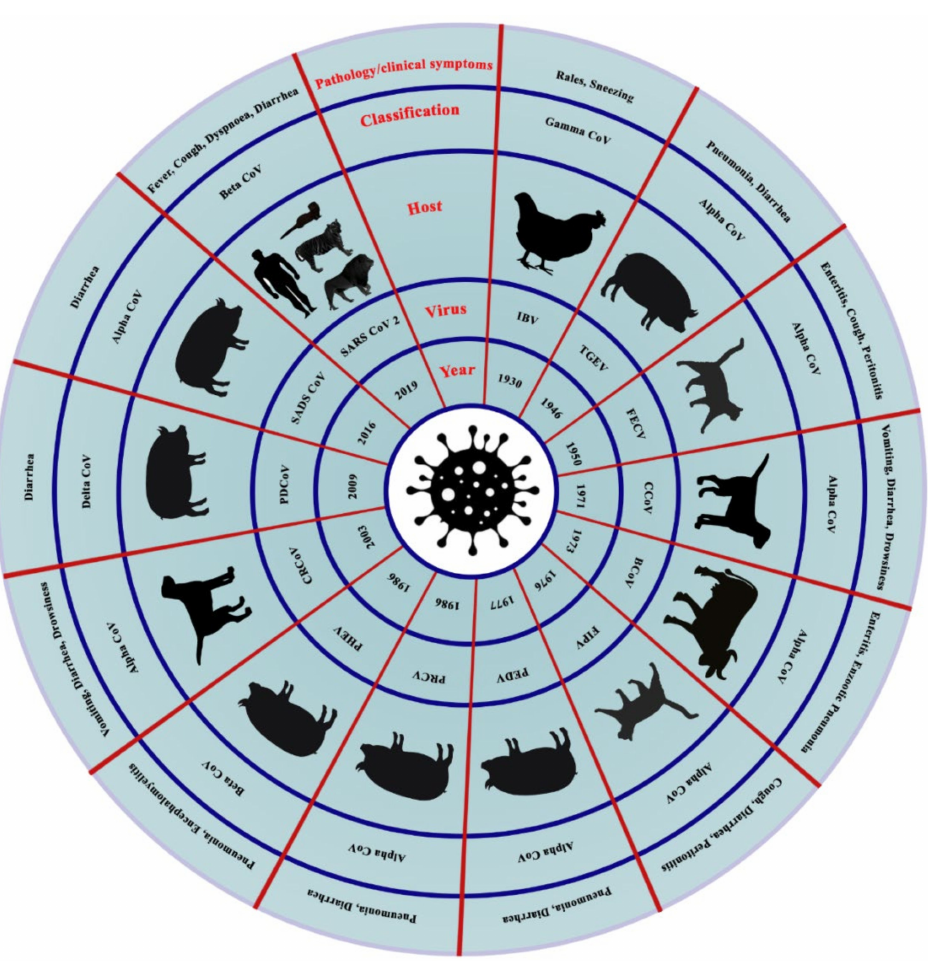
Figure 1. The emergence of animal coronaviruses in the world. The circles (inner to outer) indicate- the year of emergence, virus’s name, host species, the genus of coronavirus, and primary clinical signs. IBV: Infectious Bronchitis Virus; TGEV: porcine transmissible gastroenteritis coronavirus; FECV: Feline Enteric Coronavirus; CCoV: Canine Coronavirus; BCoV: Bovine Coronavirus; FIPV: Feline Infectious Peritonitis Virus; PEDV: Porcine Epidemic Diarrhea Virus; PRCV: Porcine Respiratory Coronavirus; PHEV: Porcine Hemagglutinating Encephalomyelitis Virus; CRCoV: Canine Respiratory Coronavirus; PDCoV: Porcine Delta Coronavirus; SADS: Swine Acute Diarrhea Syndrome Virus; and SARS: Severe Acute Respiratory Syndrome